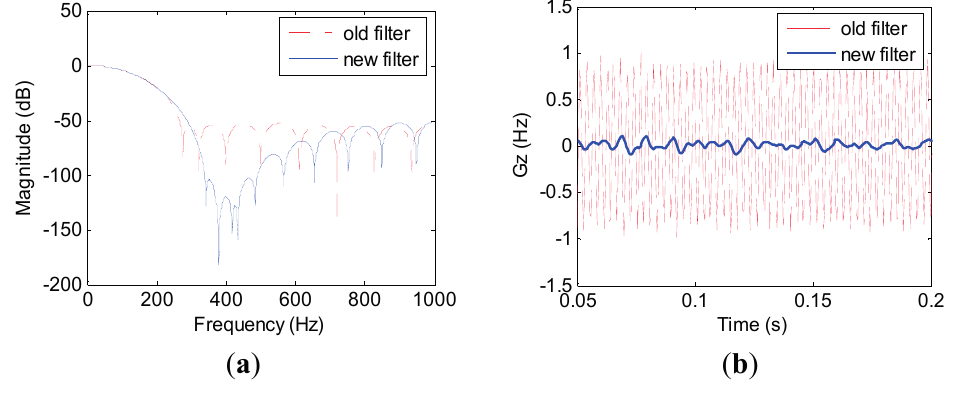
Figure 3. New FIR filter with three notches. ( a ) Amplitude frequency characteristics; ( b ) Effect comparison between new and old